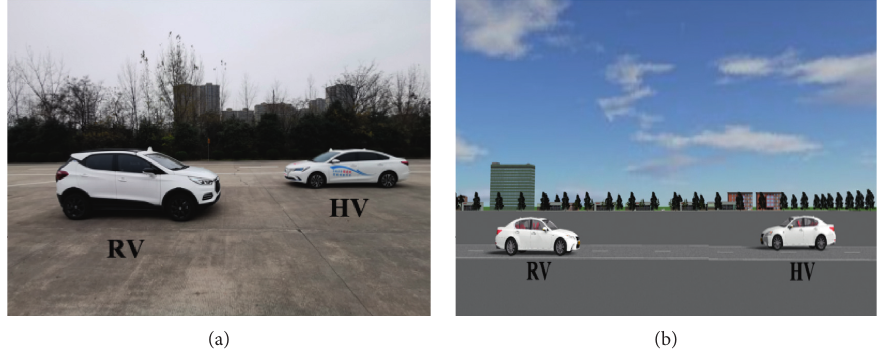
Figure 10: Cars-approaching scenario. (a) Actual rest scenario. (b) Simulation test scenario.